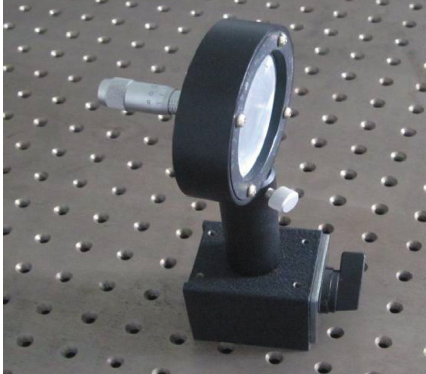
Figure 5: Schematic of the centrally loaded sample.